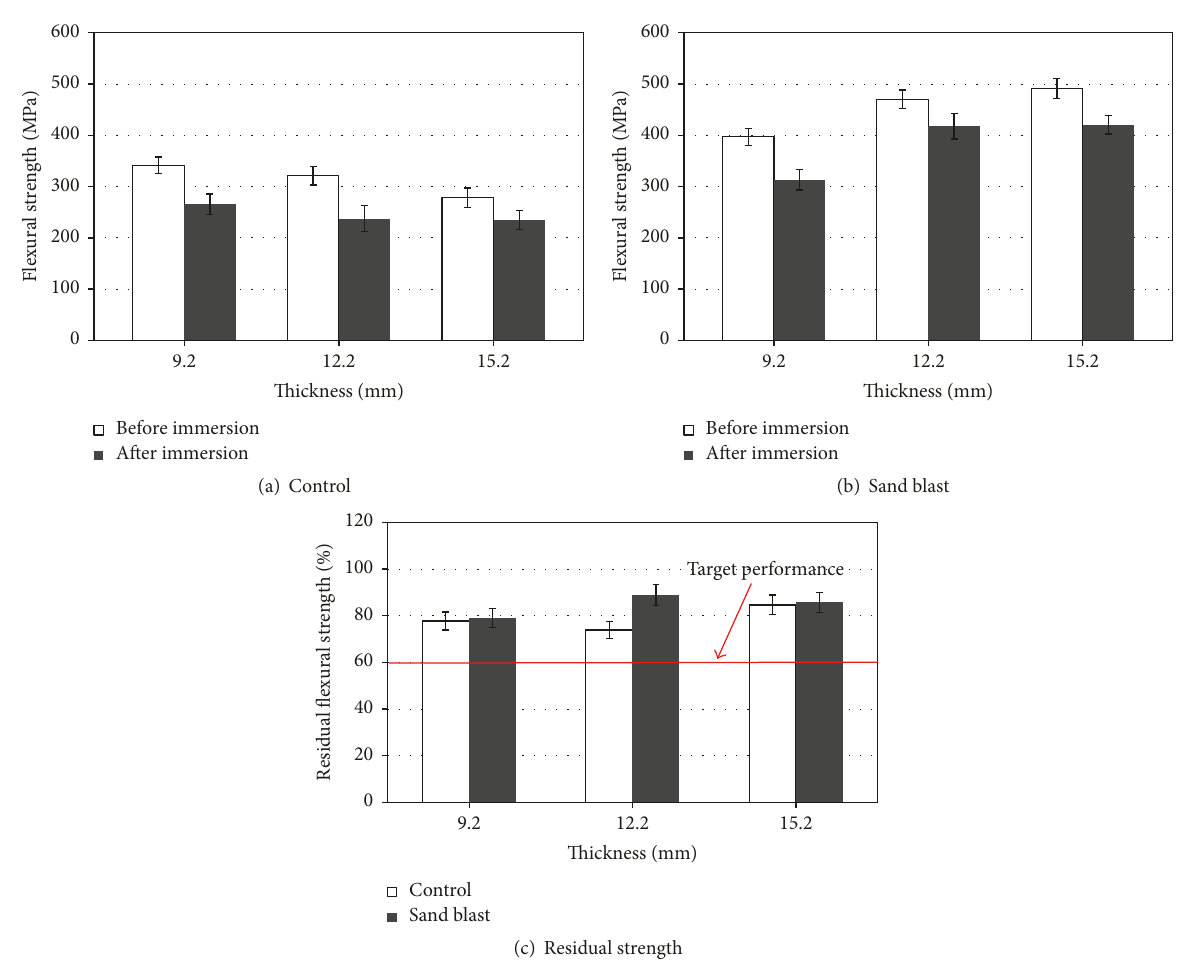
Figure 18: Flexural test results of Ca 2 Cl 2 solution